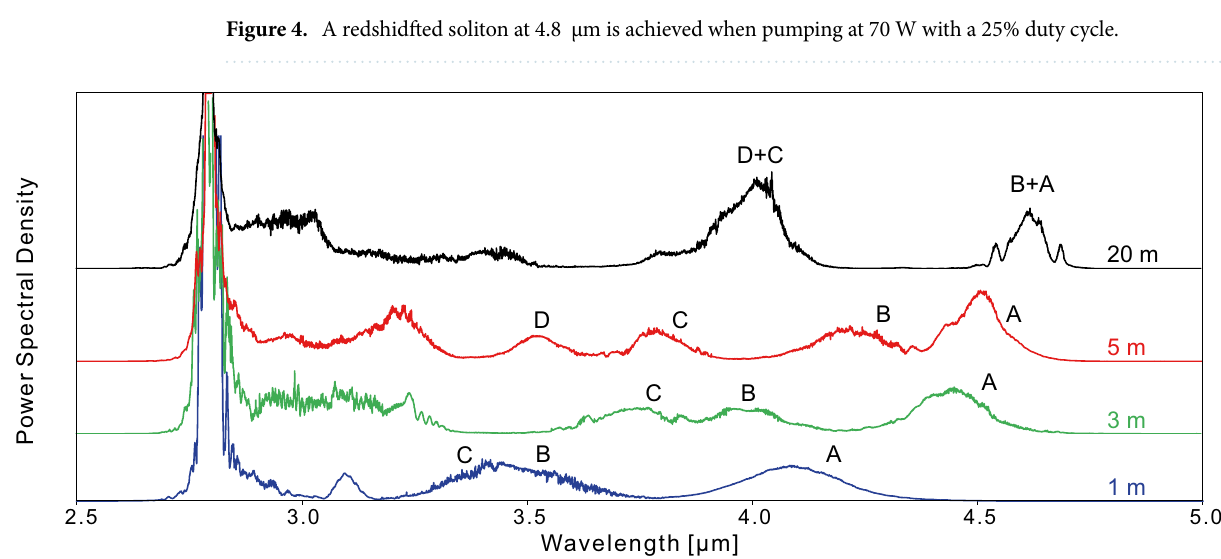
Figure 5. Power spectra in obtained after four different lengths of the InF 3 fiber and for Pp = 27.8 W. The curves are offset for a better